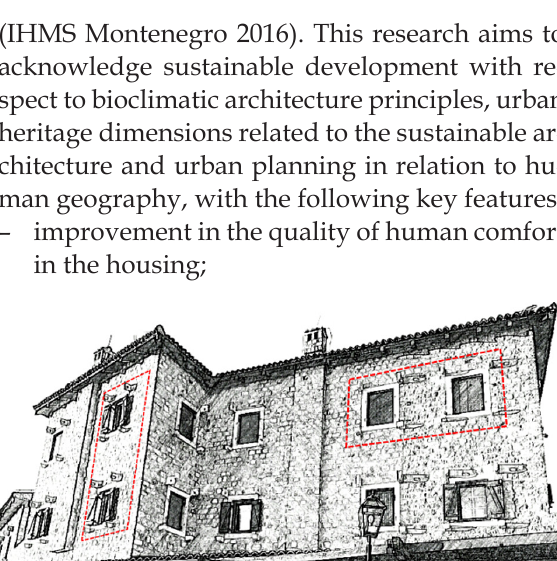
Fig. 5. Psychometric chart, comfort zone of human thermal comfort.